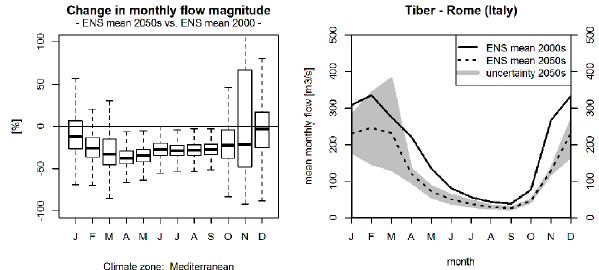
Fig. 13. Direction of change in the 2050s plotted for all grid cells of the Mediterranean climate zone (left) and the Tiber river near Rome